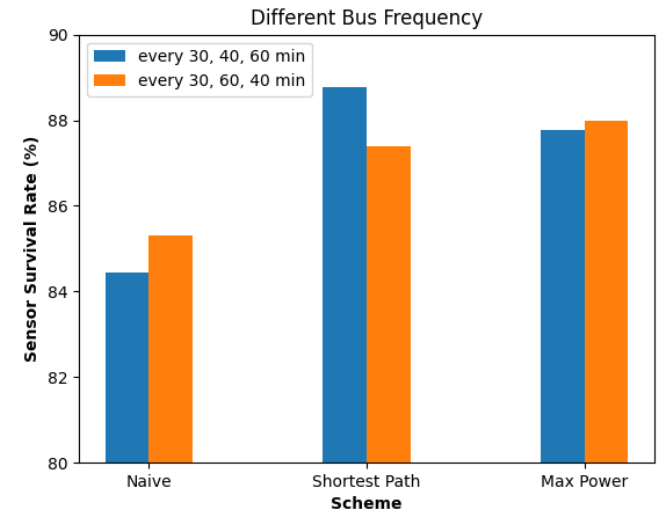
Figure 5. Impact of different bus intervals on the survival rate of sensors.